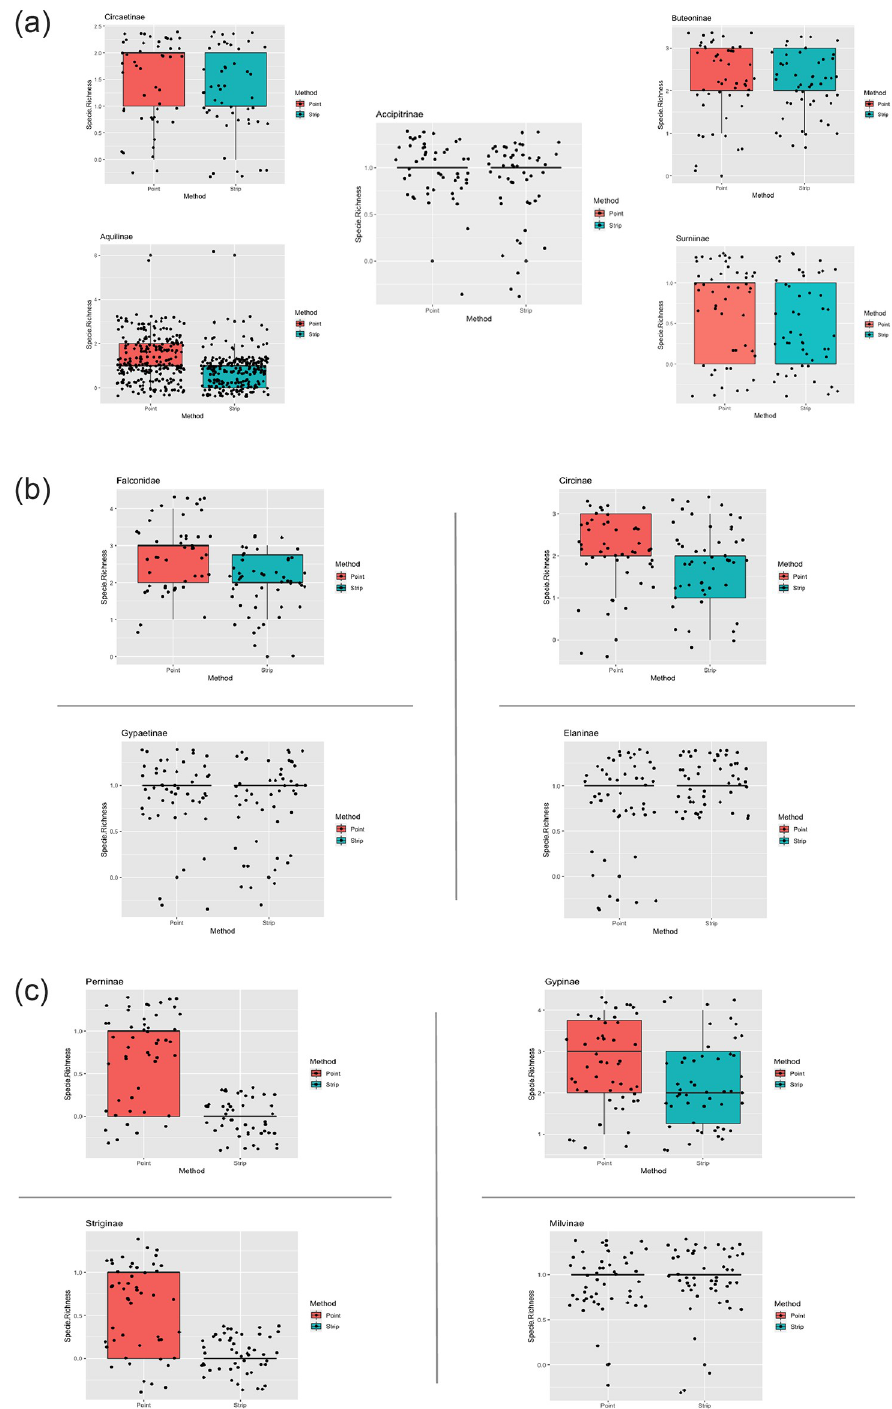
Fig 6. Boxplots with jitter points representing the species richness for 13 different sub-families and 1 species unidentified of raptors in winter seasons using roadside point count and strip transect methods in the arid region of